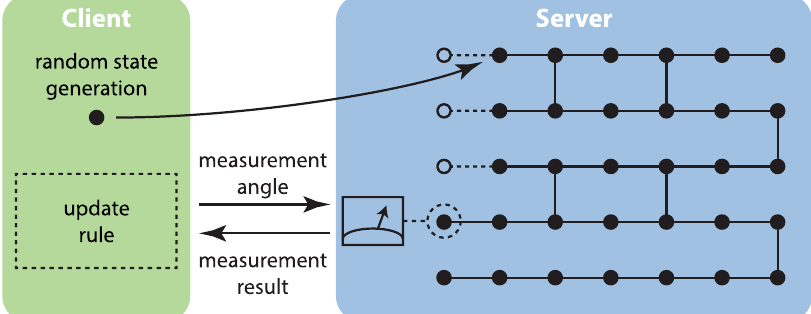
Fig. 5 A depiction of the Universal Blind Quantum Computation (UBQC) protocol introduced in ref. 10. The client prepares random single qubit states which are then sent to the server to be entangled. For each qubit in turn, the client computes a measurement angle which is sent to the server, which returns the result to the client for inclusion in the calculation of subsequent measurement